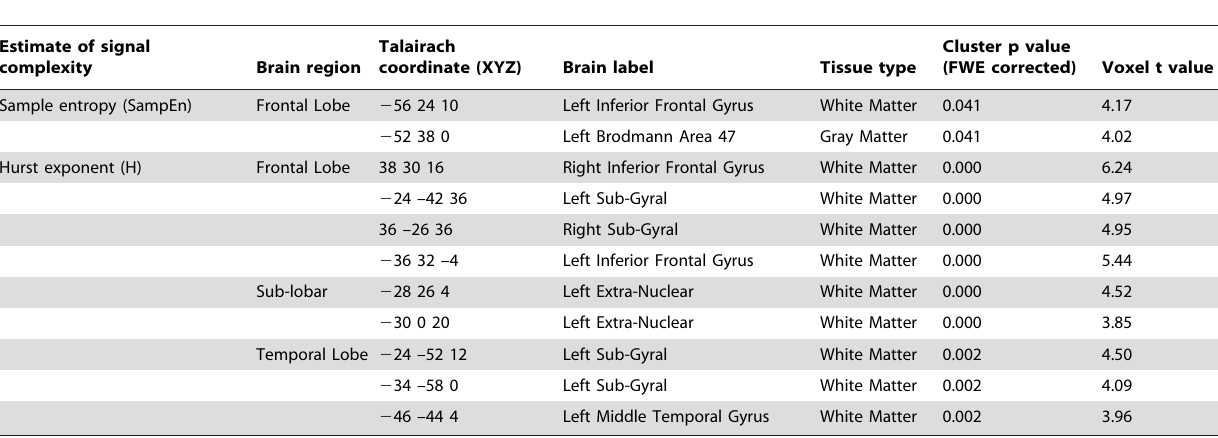
Table 2. Anatomical location of the regions discriminated in SampEn and Hurst exponent differences between Controls and patients with schizophrenia after adjusting for both age and sex differences